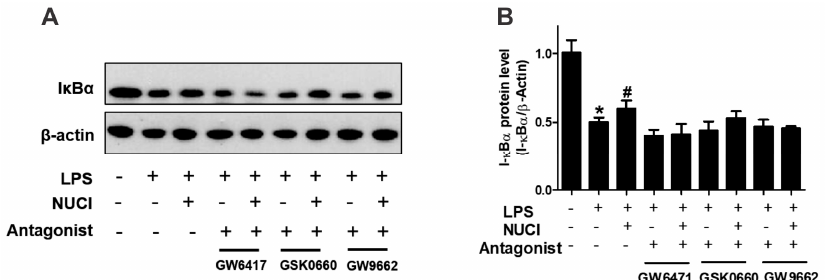
Figure 5. Anti-inflammatory effects of nuciferine on the LPS-induced inflammatory response, are PPARs dependent. RAW264.7 cells were pretreated with GW6417/GSK0660/GW9662, for 12 h, followed by the Nuciferine incubation and then stimulated by the LPS with a nuciferine withdrawal. Levels of the expression of I κ B α were detected by Western blotting. * p < 0.05 vs. control group; # p < 0.05 vs. LPS